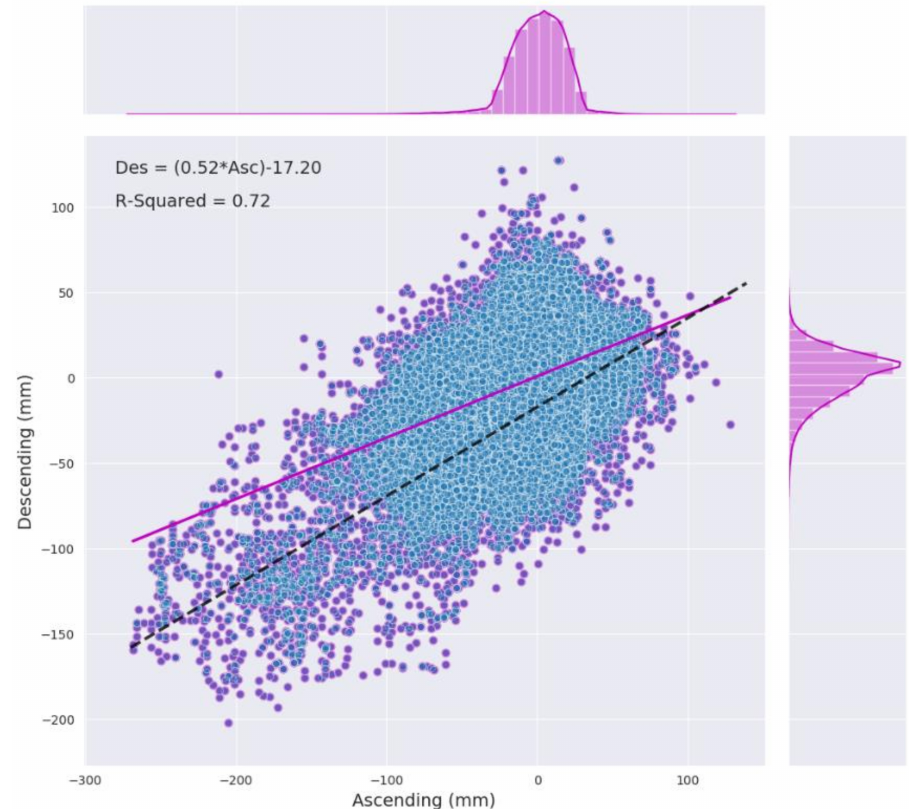
Figure A1. The scatterplot of cumulative (from 2017 to 2020) surface deformations observed in ascending and descending path LOS. The ad-hoc plots on the top and right side are the histograms of respective LOS surface deformation. The black dashed line denotes the best-fit line for values less than − 30mm, and the equation of this line has shown on the top left. The solid pink line represents the best-fit line of the original LOS surface